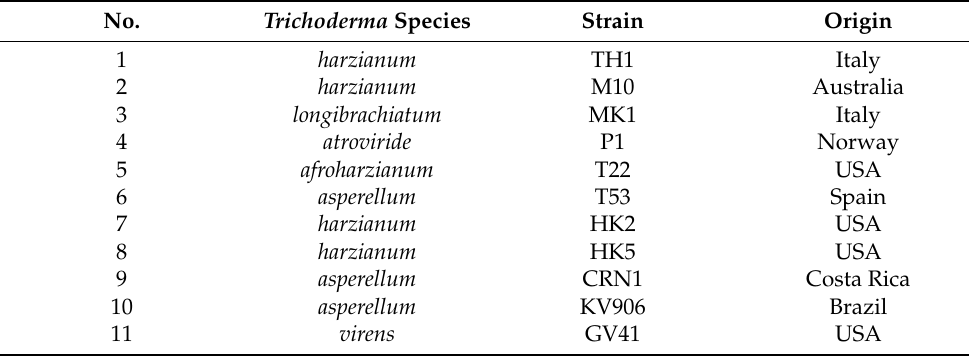
Table 2. List of Trichoderma species and strains used for the